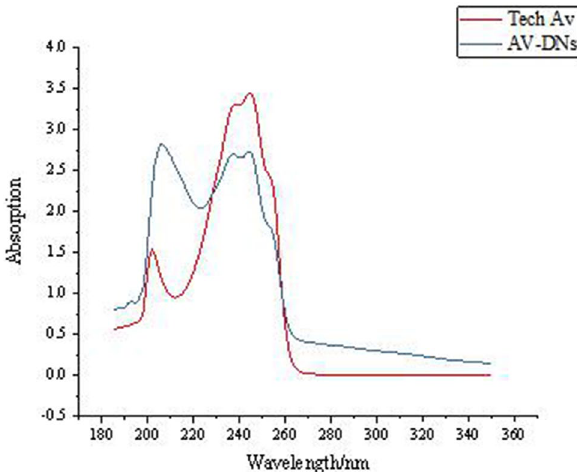
Figure 5. UV–visible spectra of tech. Av and Av-NDs.